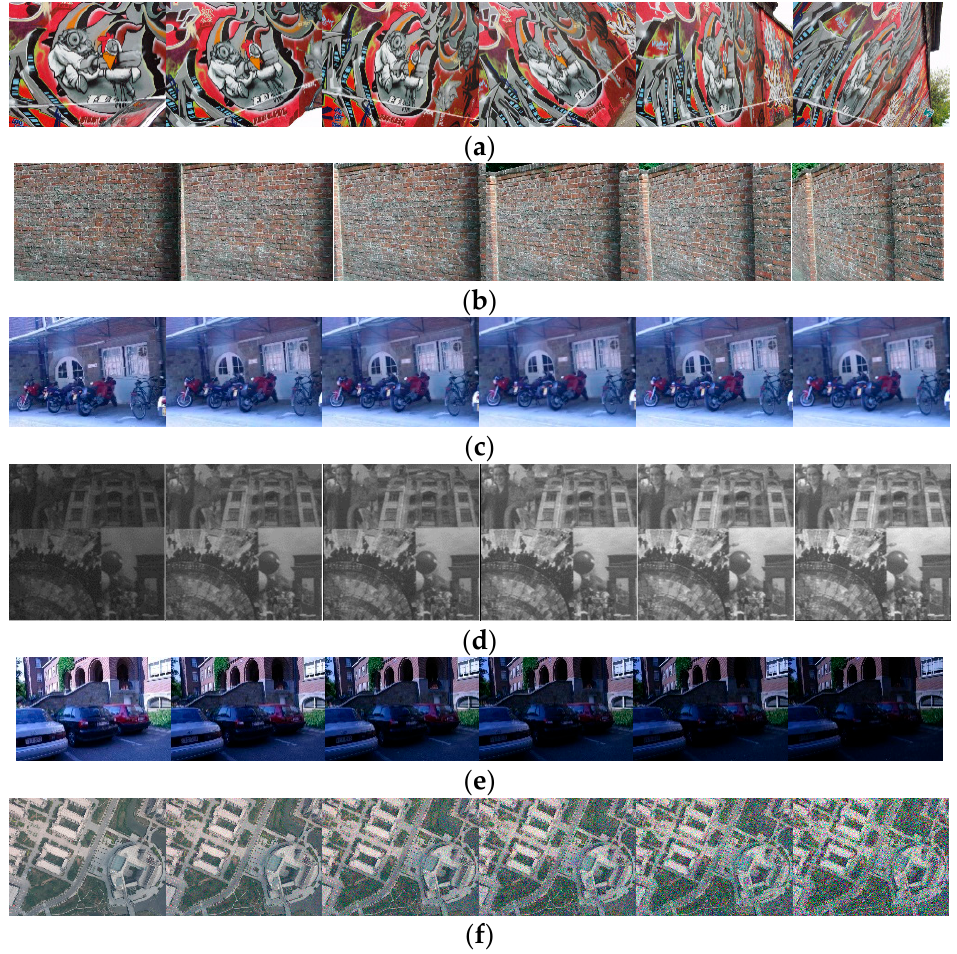
Figure 4. Test image sequences with affine distortion, scale distortion, illumination change and noise change in images. ( a ) graffti: the image affine distortion increasing from left to right; ( b ) wall: the image affine distortion increasing from left to right; ( c ) bikes: the image scale distortion increasing from left to right; ( d ) mosaic: the image illumination increasing from left to right; ( e ) Leuven: the image illumination decreasing from left to right; ( f ) library: the image noise increasing from left to right.